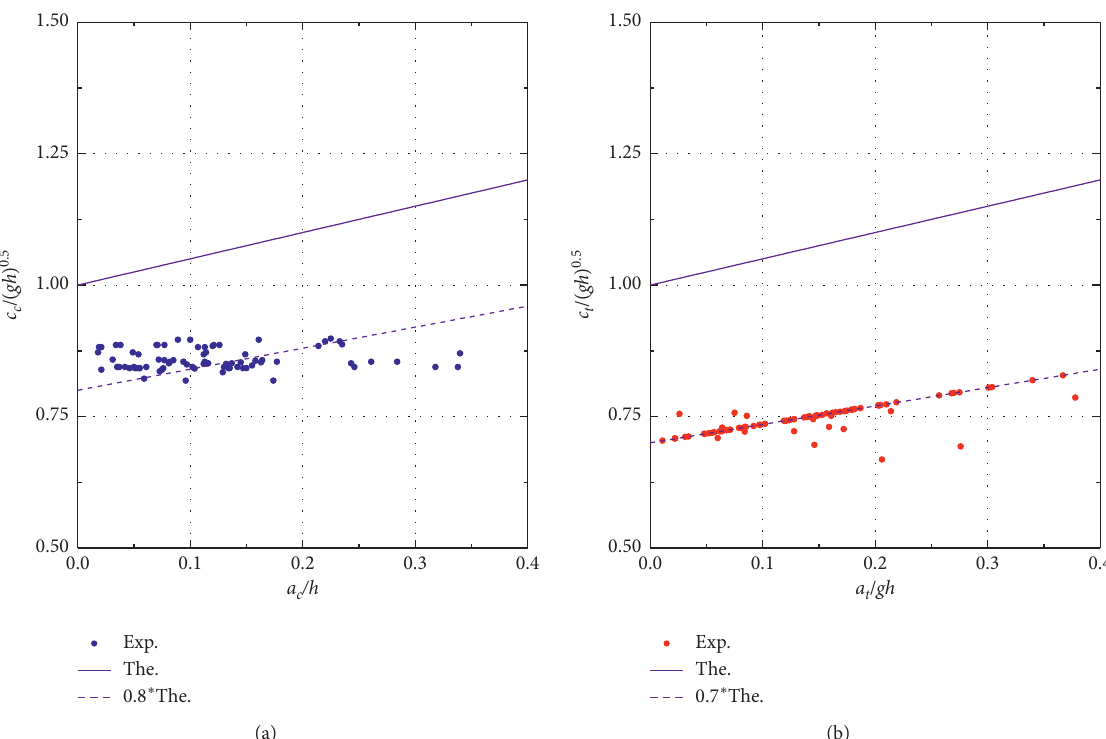
Figure 12: The relative wave propagation celerity. Exp. represents the experimental value. The. represents the theoretical value of the solitary propagation